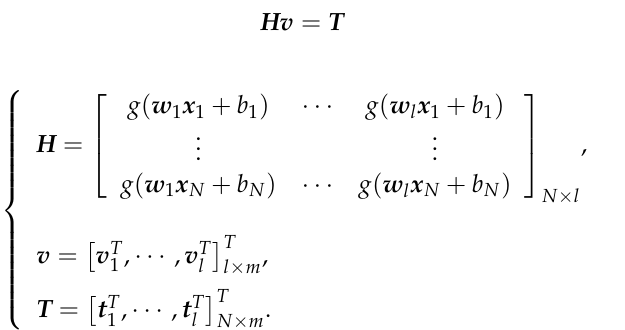
where g ( x ) is the excitation function, w i = [ w i 1 , w i 2 , . . . , w in ] T is the weight coefficient of the connection between the i -th node of the hidden layer and the input layer, v i = [ v i 1 , v i 2 , . . . , v im ] T is the weight coefficient of the connection between the i -th node of the hidden layer and the output layer, and b i is the threshold of hidden layer nodes. In the case of l = N , Equation (9) is defined